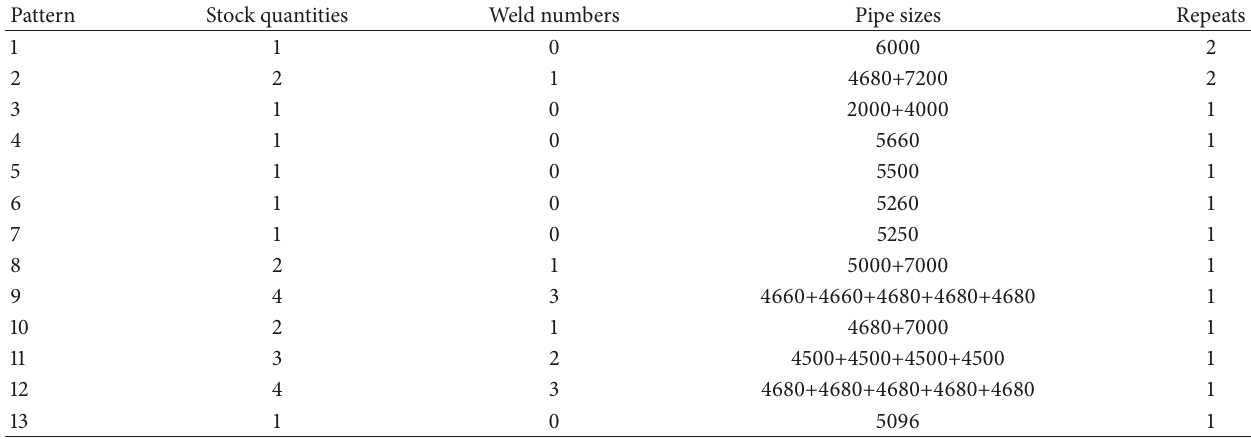
Table 5: Minimal cutting-and-welding patterns for 𝜋 𝑤 = 0.3𝜋 1